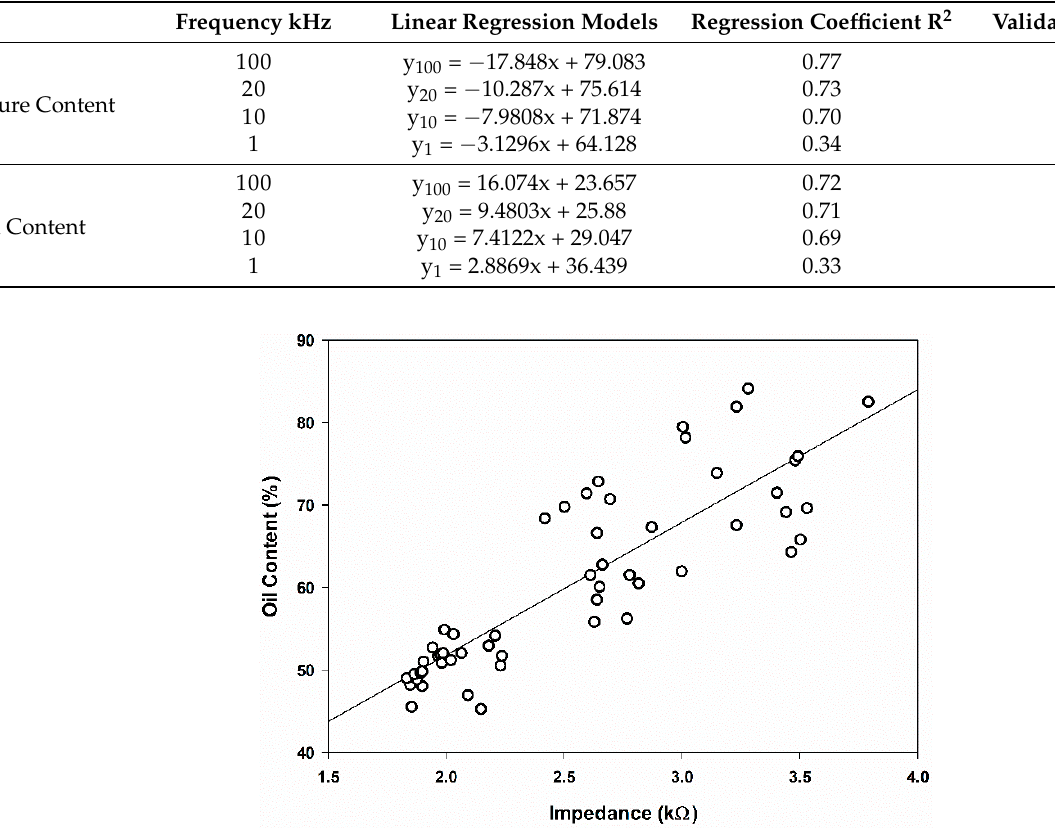
Figure 5. Effect of oil content on the impedance value at 100 kHz. Table 5. Linear regression model and RMSE validation for moisture and oil content.